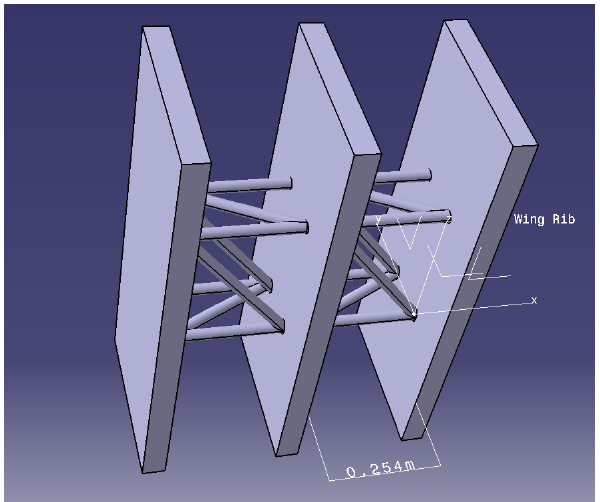
Figure 3. Configuration of structural element connections in morphing Wing, Topology